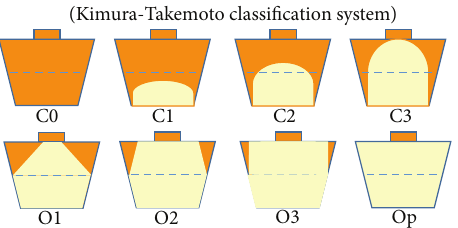
Figure 1: This atrophic border is the boundary between the pyloric and fundic gland regions, which can be recognized endoscopically based on the difference in color and height of the gastric mucosa on either side of the border. There are four types of endoscopic atrophic gastritis: C0-C1, C2-C3, O1-O2, and